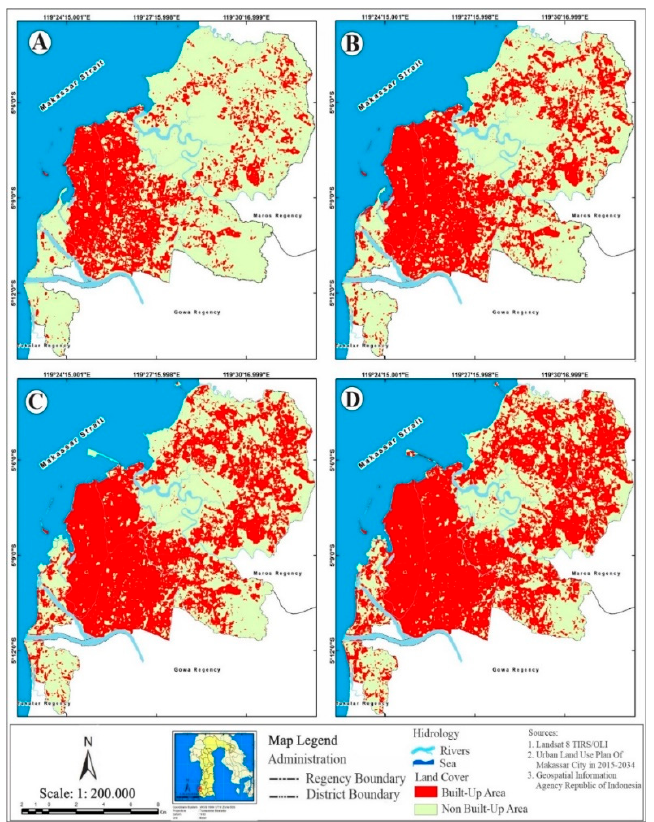
Figure 6. Comparison of the urban sprawl of Makassar City: ( A ) 2006, ( B ) 2009, ( C ) 2016, and ( D ) 2020.